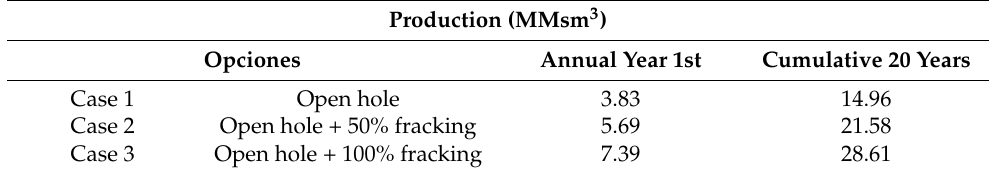
Table 4. Well production data.